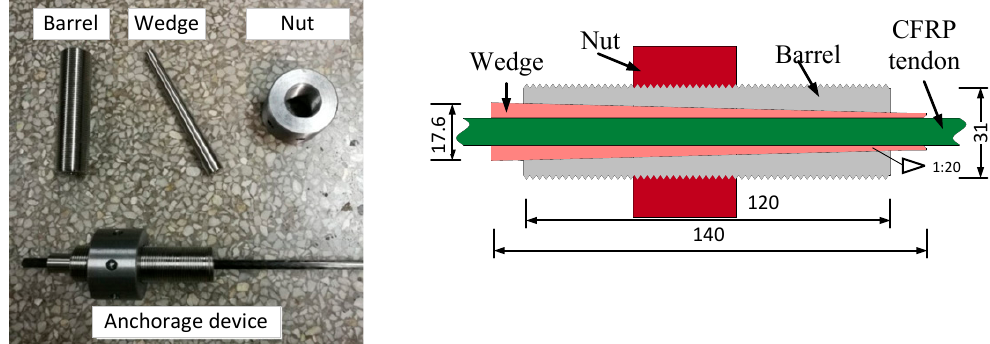
Figure 1. Wedge-type anchorage for the test. CFRP: carbon fiber reinforced polymer. (Units: mm)